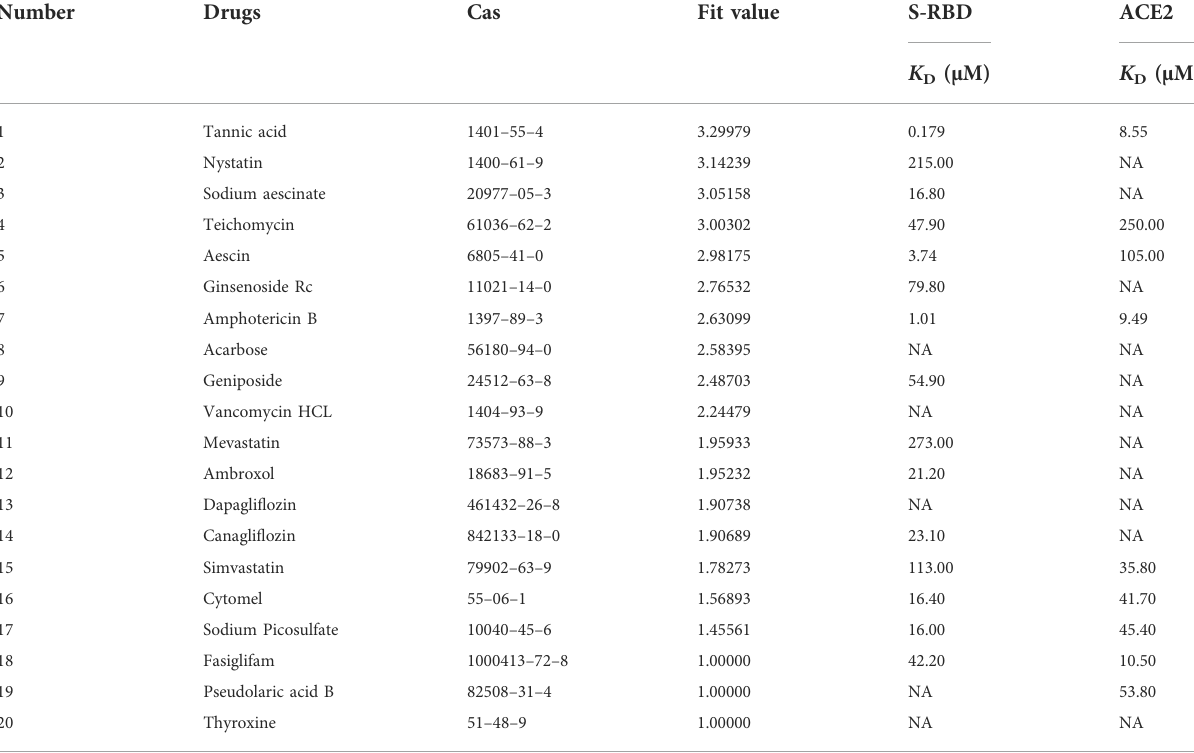
TABLE 1 Virtual screening of SARS-CoV-2-RBD-hACE2